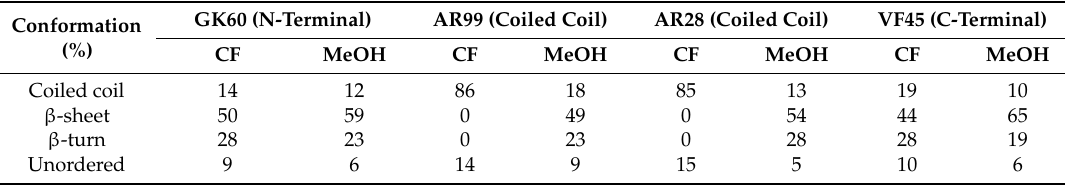
Table 1. Molecular structure of peptides from different regions of the honeybee silk protein, determined from deconvolution (Supplementary Figure S2) of the Fourier Transform Infrared (FTIR) spectra of cast films (Figure 2) before and after methanol